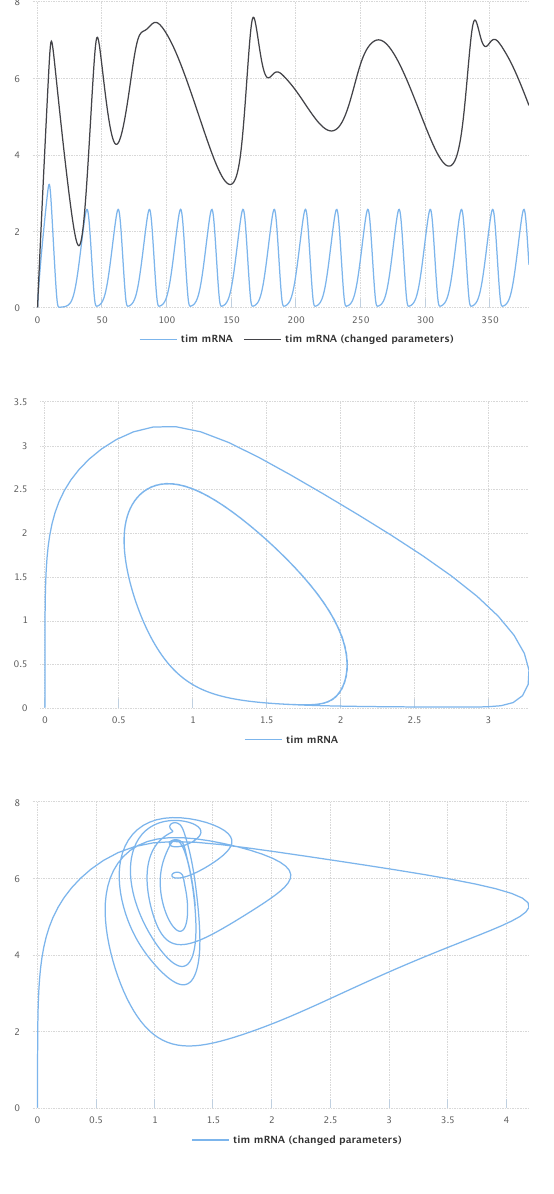
Figure A.17: The simulation result gained from the simulation description given in Listing A.10. Simulation with SED-ML web tools [2].